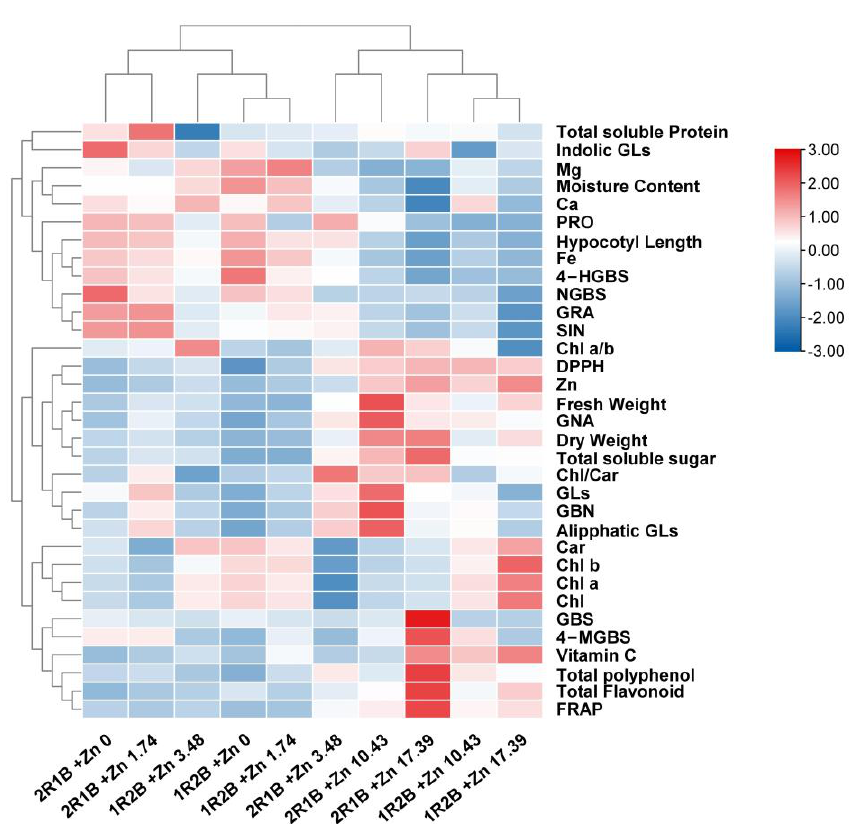
Figure 7. Cluster heat map analysis of flowering Chinese cabbage sprouts (FCCS) grown under combination of Zn concentration and R-B ratio (ratios of red and blue light). Results are visualized using a false color scale, with blue and red indicating a decrease and an increase in the response parameters, respectively.